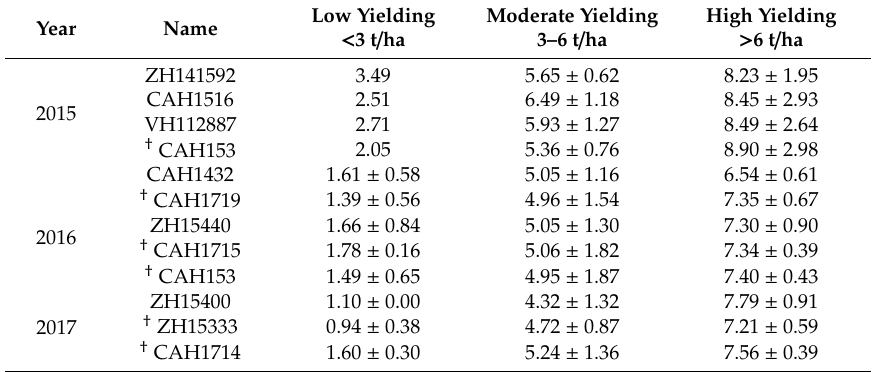
Table 3. Grain yield performance of the best entries across di ff erent yielding locations from 2015 to 2017.